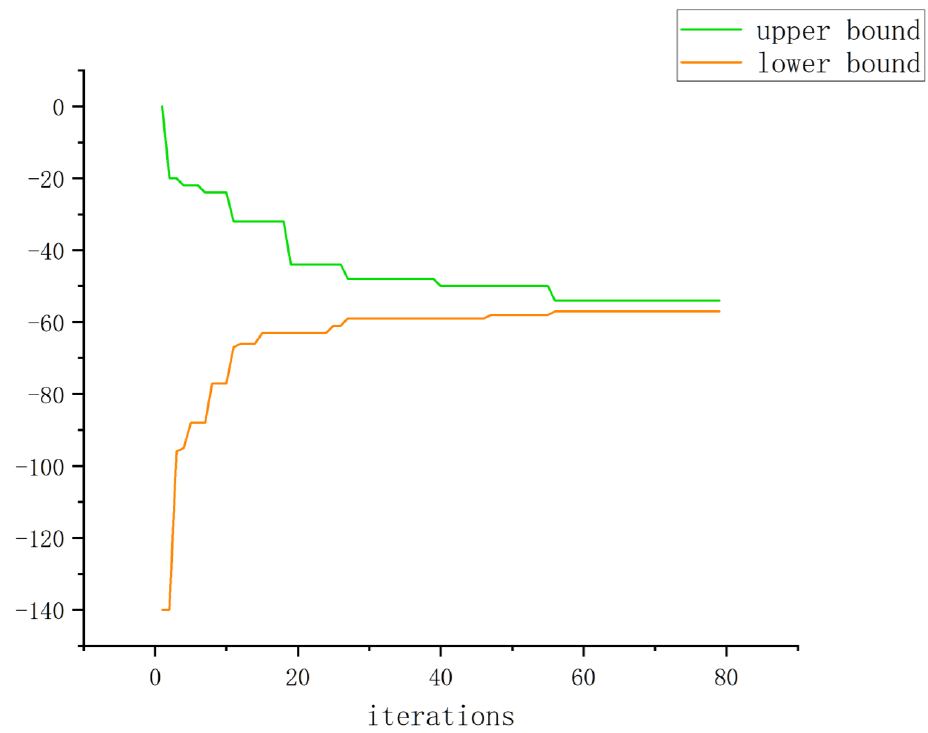
Figure 6. Upper and lower bounds of the objective function value of scenario 1.